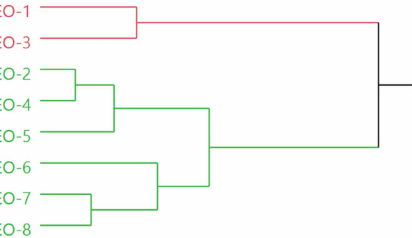
Figure 3. Dendrogram of the Rhus coriaria samples resulting from the EO analysis. The score and the loading plot of the principal component analysis are reported in Figure 4. The distribution of the samples in the score plot was comparable to that of the HCA. EO-1 and EO-3, belonging to the pink cluster, were plotted in the rightmost area of the right quadrants (PC1 > 0), the first in the upper quadrant (PC2 > 0), and the latter in the bottom one (PC2 < 0). The samples of the green cluster occupied almost the whole remaining part of the plot, while maintaining the internal partition evidenced by the HCA. The samples EO-2, EO-4, and EO-5, indeed, were plotted in the upper left quadrant (PC1 < 0; PC2 > 0), EO-7 and EO-8 were positioned in the bottom left one (PC1 < 0; PC2 < 0), and EO-6 was plotted in the upper right quadrant (PC1 > 0; PC2 > 0), in an intermediate position among the other green samples, although the HCA EO-6 cluster was close to EO-7 and EO-8 which were collected from the Al-Salt and Al-Fuheis city that lie in the same altitude. The commercial samples 1, 3, 4, 5, and 8 that were collected from market does not show cohesiveness in their chemical behavior as they might have originated from different altitudes or locations.